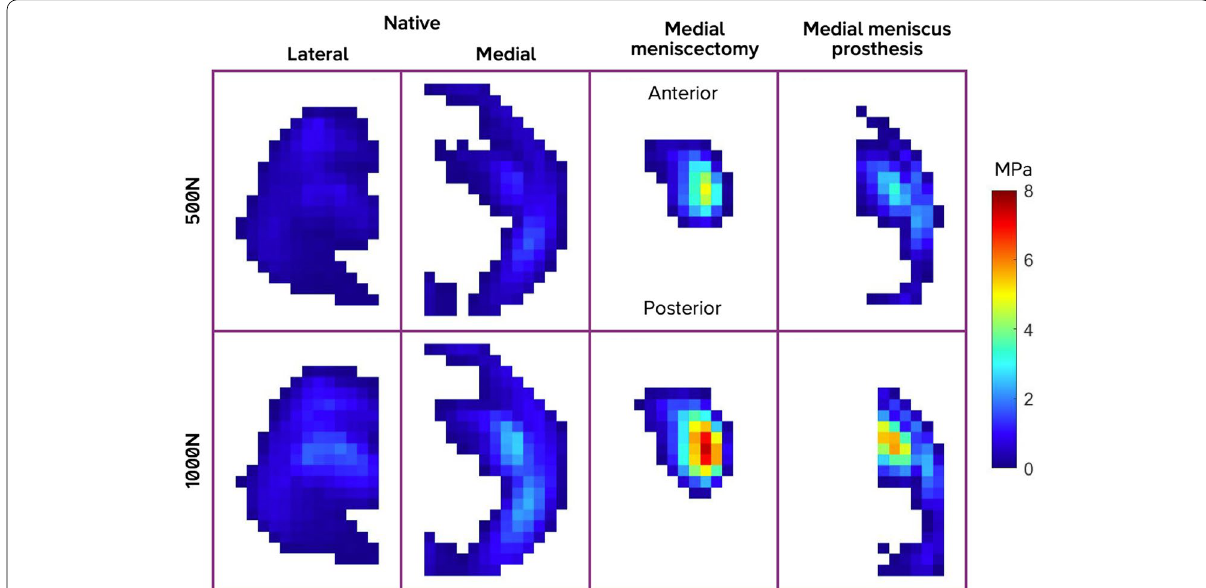
Fig. 11 Representative example of the pressure distribution in the different conditions in a cadaveric knee